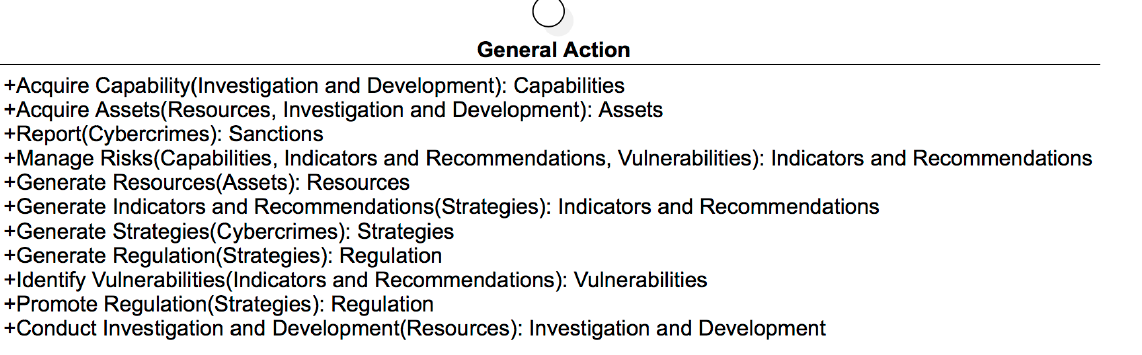
Figure 20. Entities’ General actions.